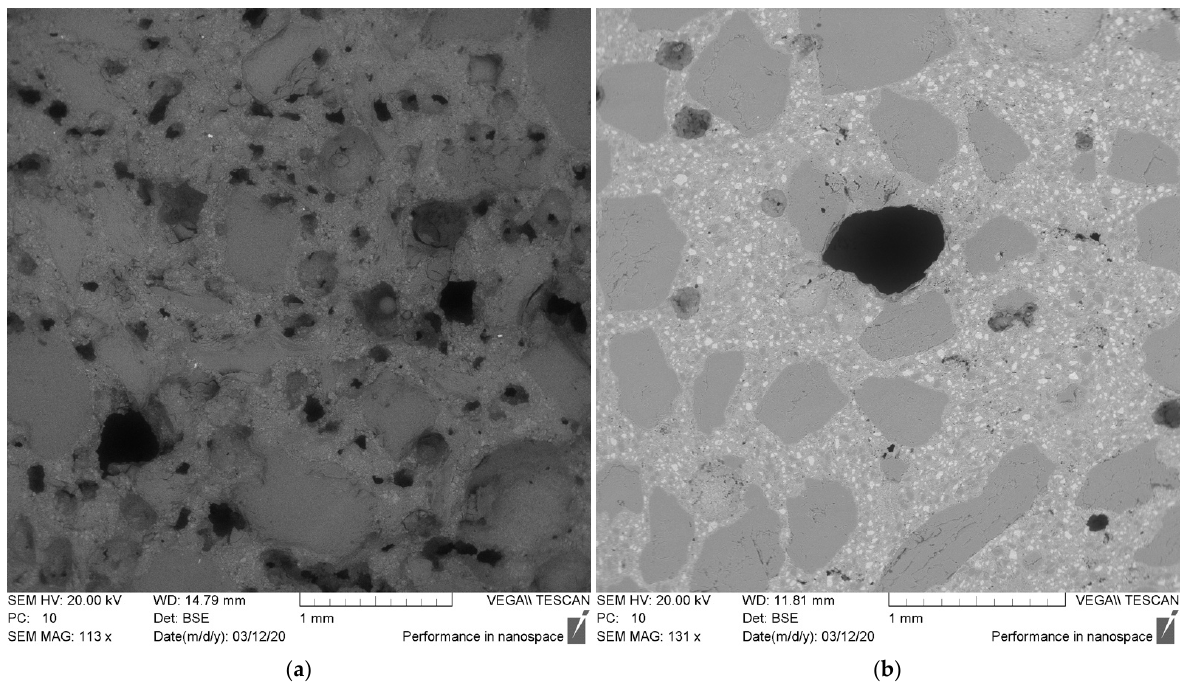
Figure 5. Microstructure after ASR testing. ( a) GGP HPC 100, ( b ) REF HPC. According to Dhir et al. [20], there is no relationship between the amount of glass that is used and the expansion that is caused by ASR. At the same time, he claims that me ‐ takaolin, fly ash, or silica fume can also affect the ASR expansion. In this work, in the proposed mixtures of the type GPP HPC 50 and GPP HPC 100, microsilica was removed from the composition of the mixture. In the first pilot test, cracks formed during the setting of the concrete. The mixture was subsequently optimized, and one of the steps in the new mix was the omitting of silica fume. Therefore, this work confirms the assumption of a possible negative effect of silica fume on ASR. But, of course, it depends on the chemical properties of the material [33].